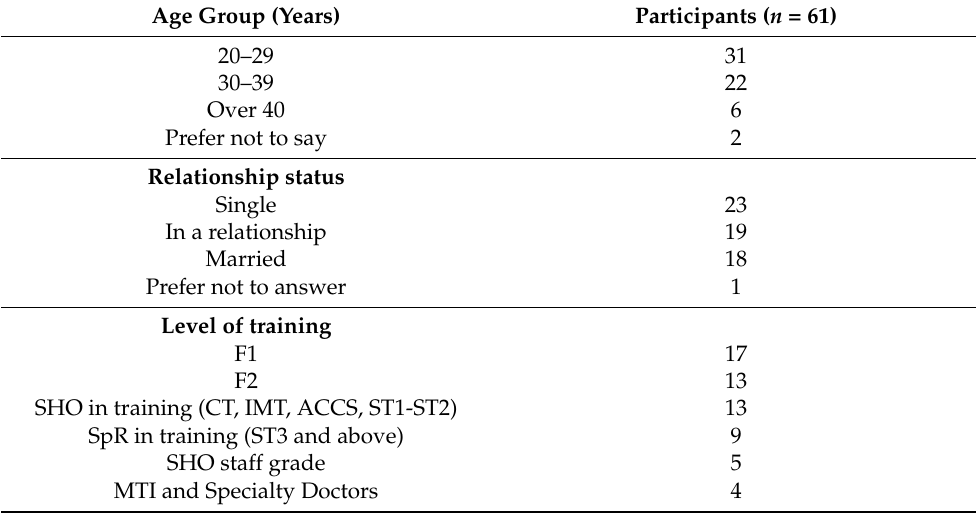
Table 1. Characteristic of the participants completing the survey.